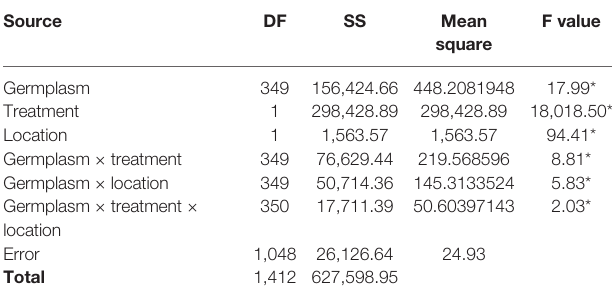
TABLE 1 | Phenotype analysis of variance (ANOVA) for barley germplasms.